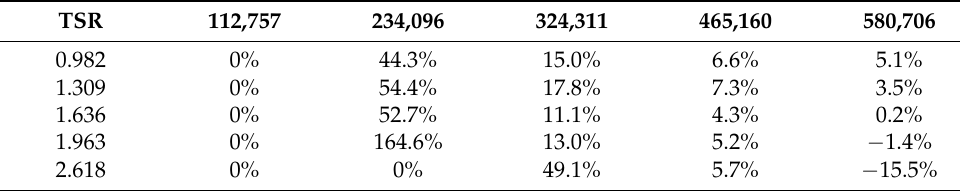
Table 4. Percentage deviation from the previous mesh of coefficient of performance.